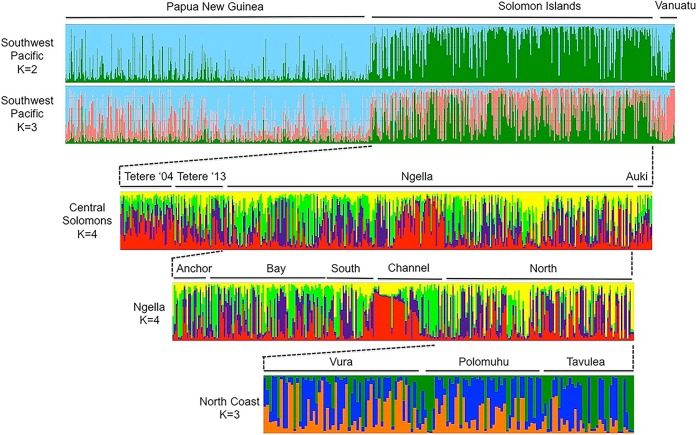
Geographical population clustering of Plasmodium vivax isolates of the Southwest Pacific.Results of STRUCTURE analysis are shown for different geographic strata. The analysis assigns P. vivax haplotypes to a defined number of genetic clusters (K) based on genetic distance. Vertical bars indicate individual P. vivax haplotype and colours represent the ancestry co-efficient (membership) within each cluster.